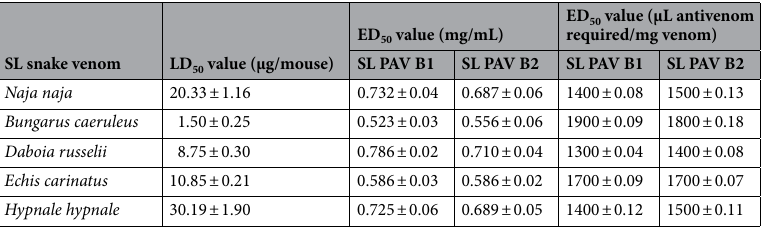
Table 2. Determination of lethality of SL venoms (LD 50 value) and neutralization of lethality (ED 50 value) of venom samples by two batches of SL PAV. Neutralization activity by PAV is expressed as mg venom neutralized per mL of antivenom. The venom stock (1 mg/mL) was used and injected in the mice at different dilution (1:8, 1:10, 1:12.5). The LD 50 and ED 50 values given below are means ± SD of five